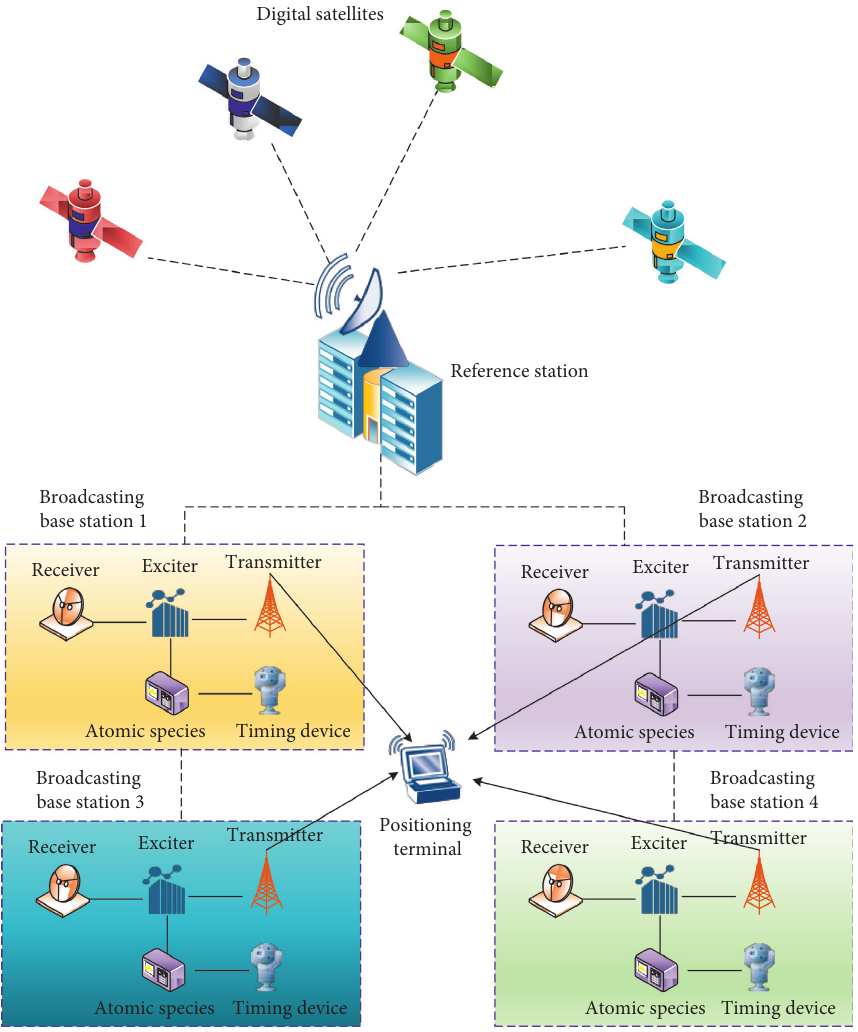
Figure 2: Composition of digital broadcasting positioning system.